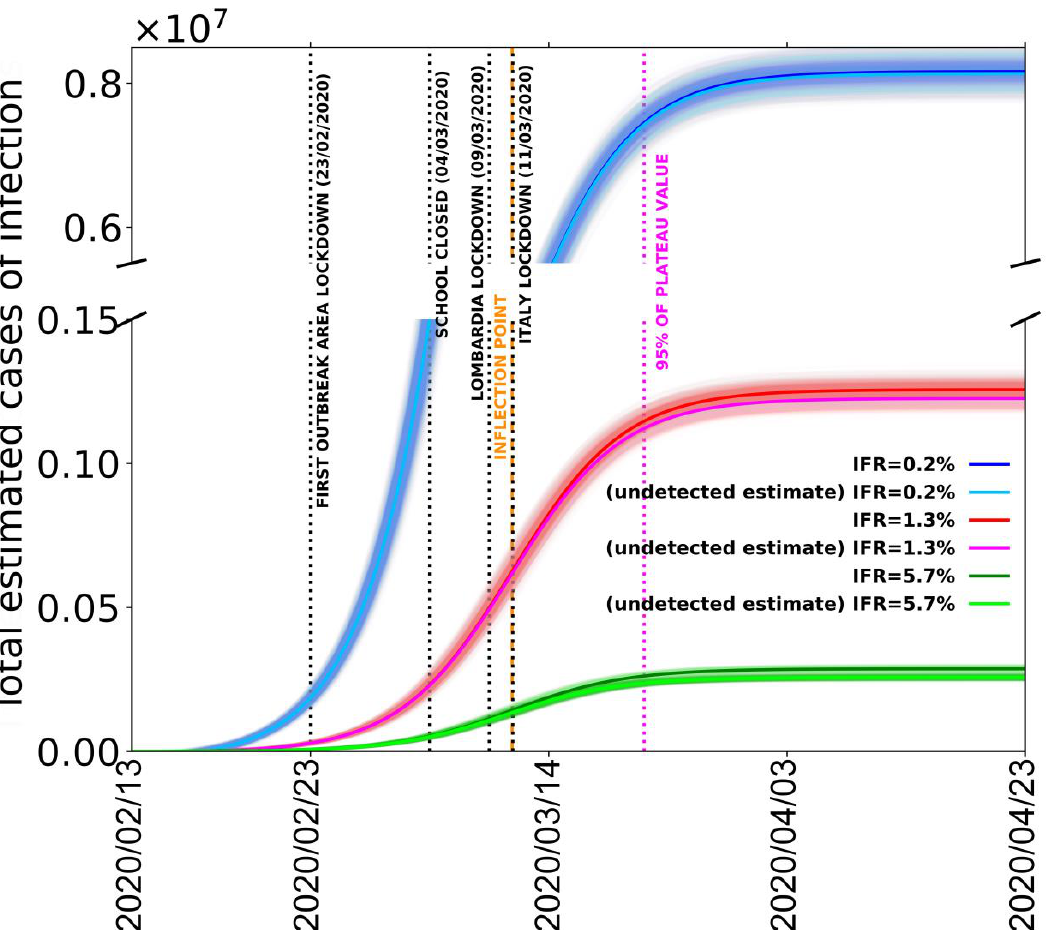
Figure 5. Estimated (total and undetected) COVID-19 cases in Italy based on three different infection fatality ratio (IFR) hypotheses: 0.2% (blue and light blue lines), 1.3% (red and pink lines), and 5.7% (green and light green lines). Blue and sky-blue solid lines represent logistic fits of total and undetected estimated cases with IFR = 0.2%, respectively. Red and pink solid lines represent logistic fits of total and undetected estimated cases with IFR = 1.3%, respectively. Green and light green solid lines represent logistic fits of total and undetected estimated cases with IFR = 5.7%, respectively. Black dotted vertical lines mark the dates of Codogno area lockdown, Italian schools’ lockdown, Lombardia lockdown, and Italy lockdown. Dark orange dashed vertical line marks the inflection points of the three curves representing the total infected estimates; magenta dotted vertical line marks the 95% of the plateau of the three curves. Shaded areas represent the family of curves obtainable by making the fit parameters vary within their confidence intervals. Best fit parameters are listed in Table